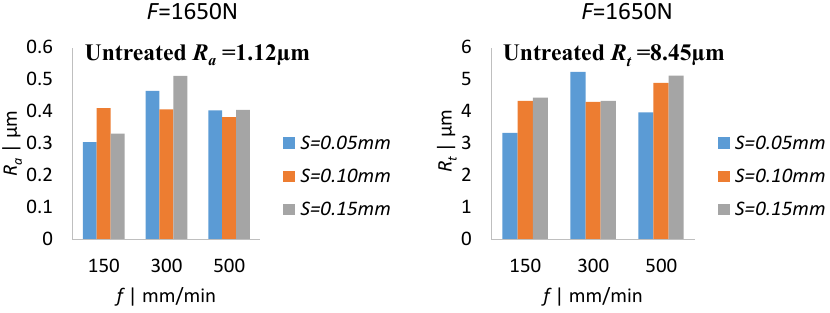
Figure 9. Effect of a burnishing step-over and feed rate on roughness— R a ( left ) and R t ( right )—at a force of 1650 N.